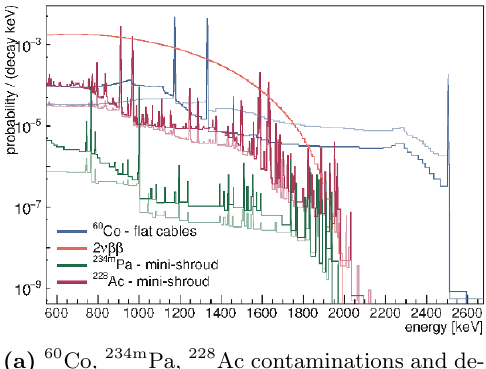
(b) 212 Bi and 208 Tl ( 232 Th chain) contamina- tions far from ((cid:12)ber shroud) and close to (mini- shrouds) the detector array.